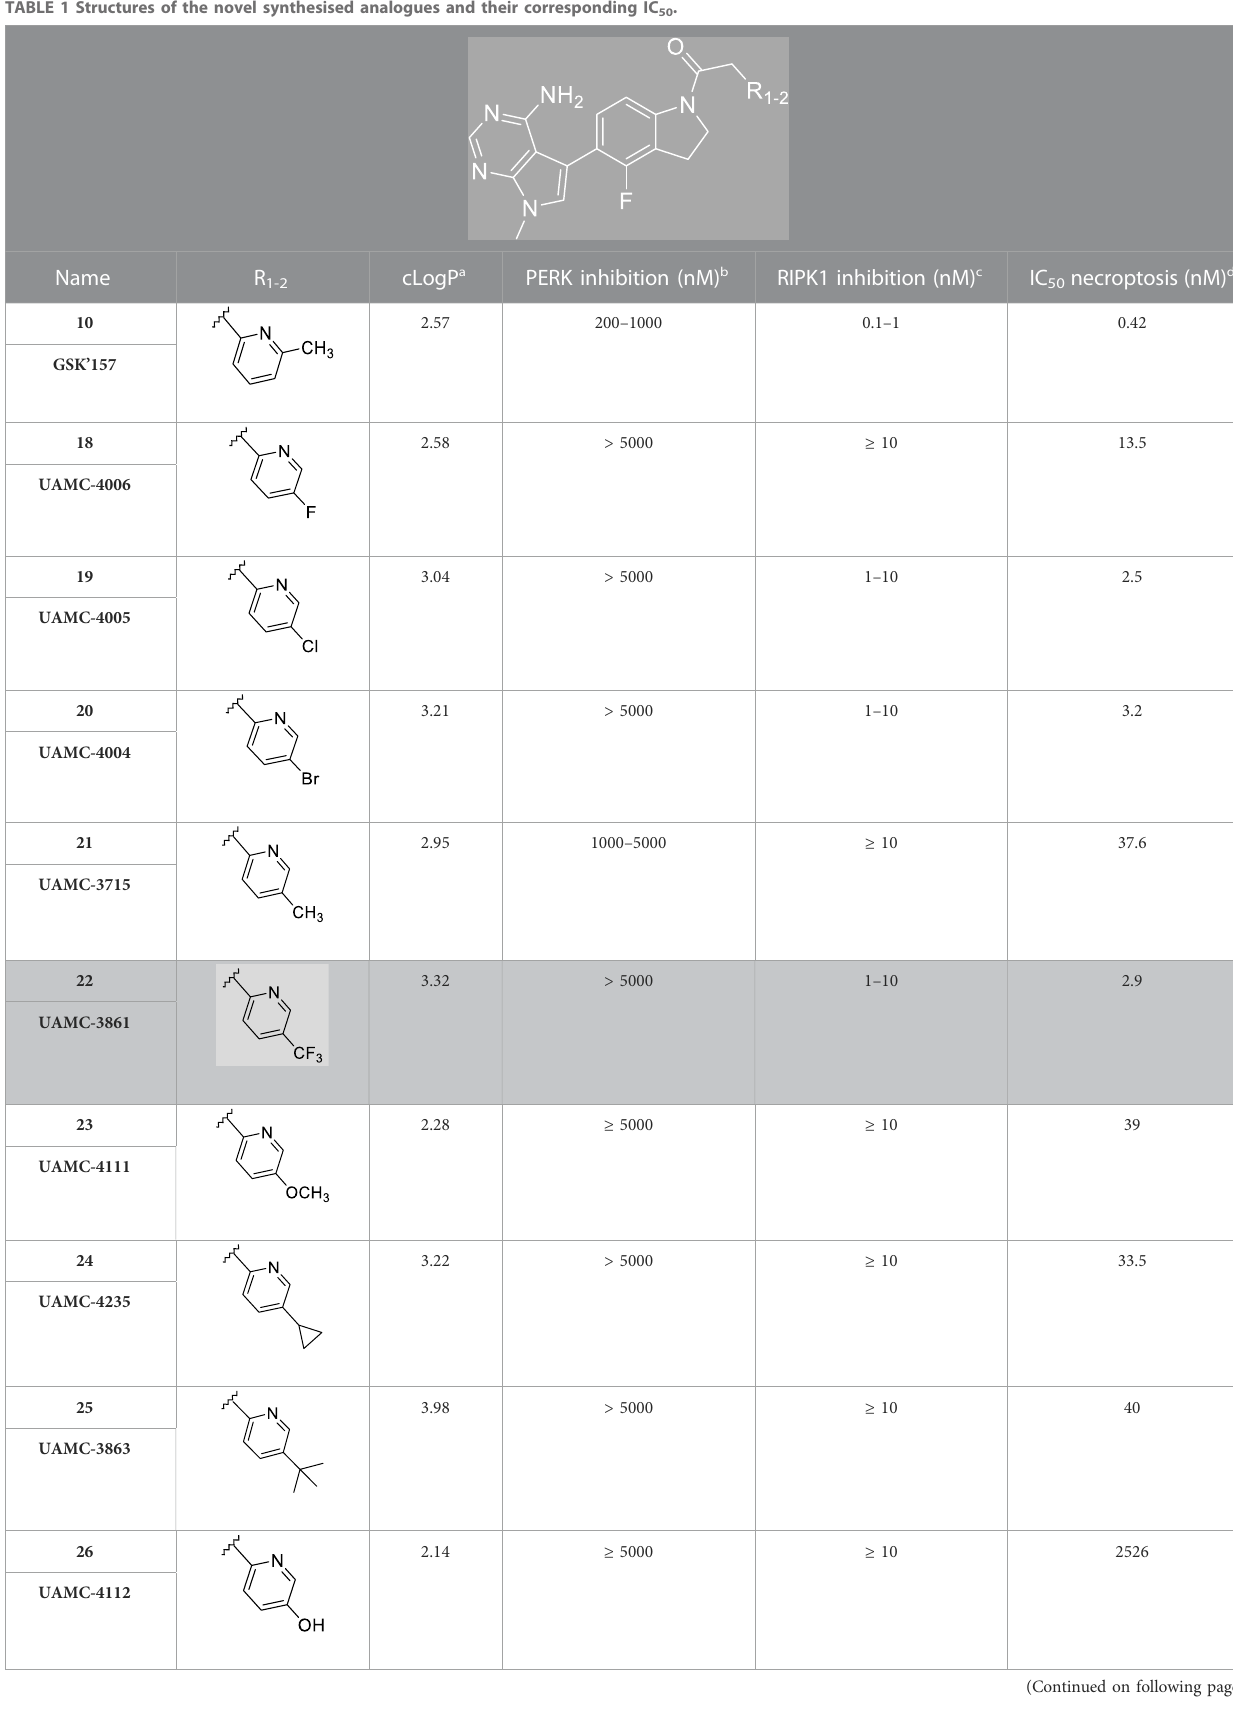
TABLE 1 Structures of the novel synthesised analogues and their corresponding IC 50